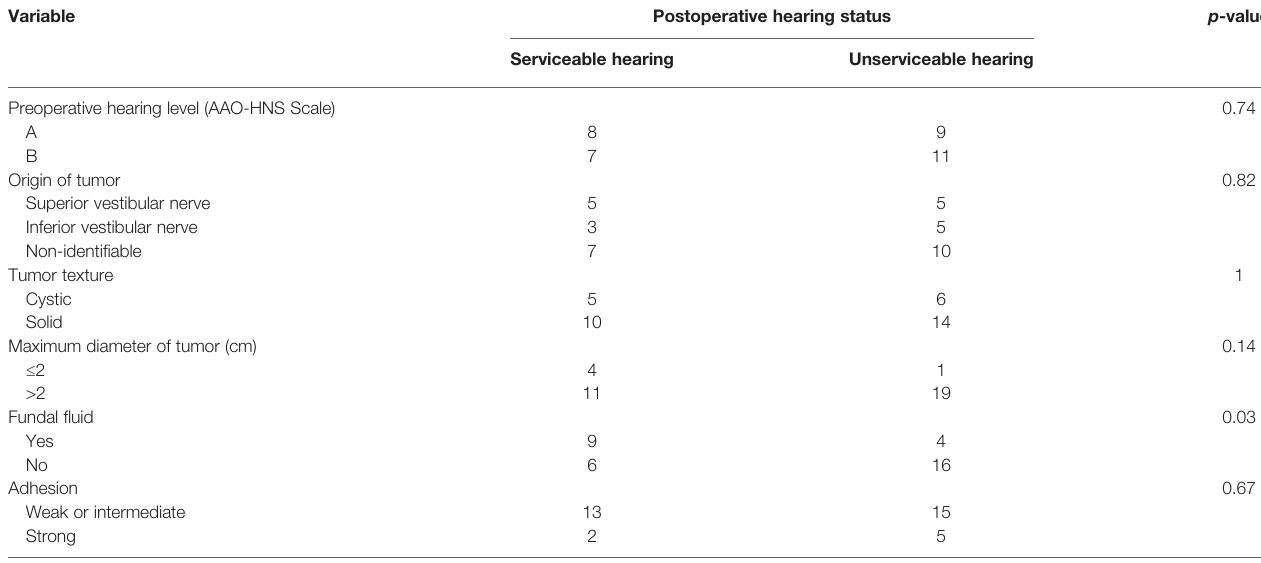
TABLE 3 | Predictors affecting postoperative hearing preservation.